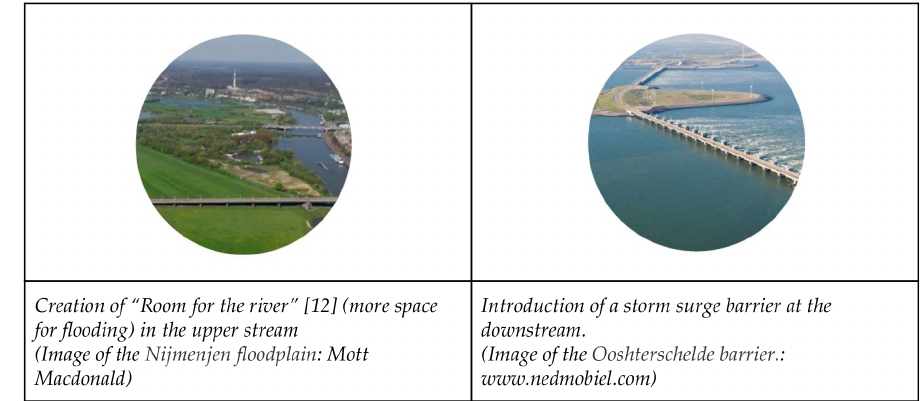
Figure 9. Design features of strategy A (anti super-levee).